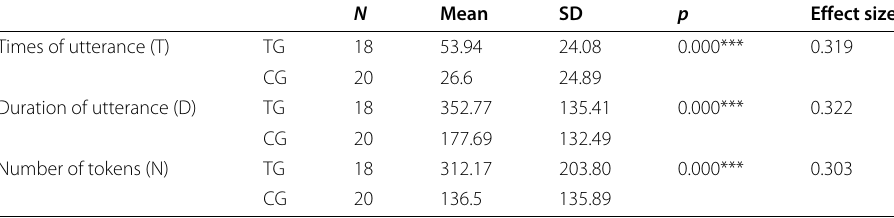
Table 8 Difference in engagement indicators for knowledge exploration phase